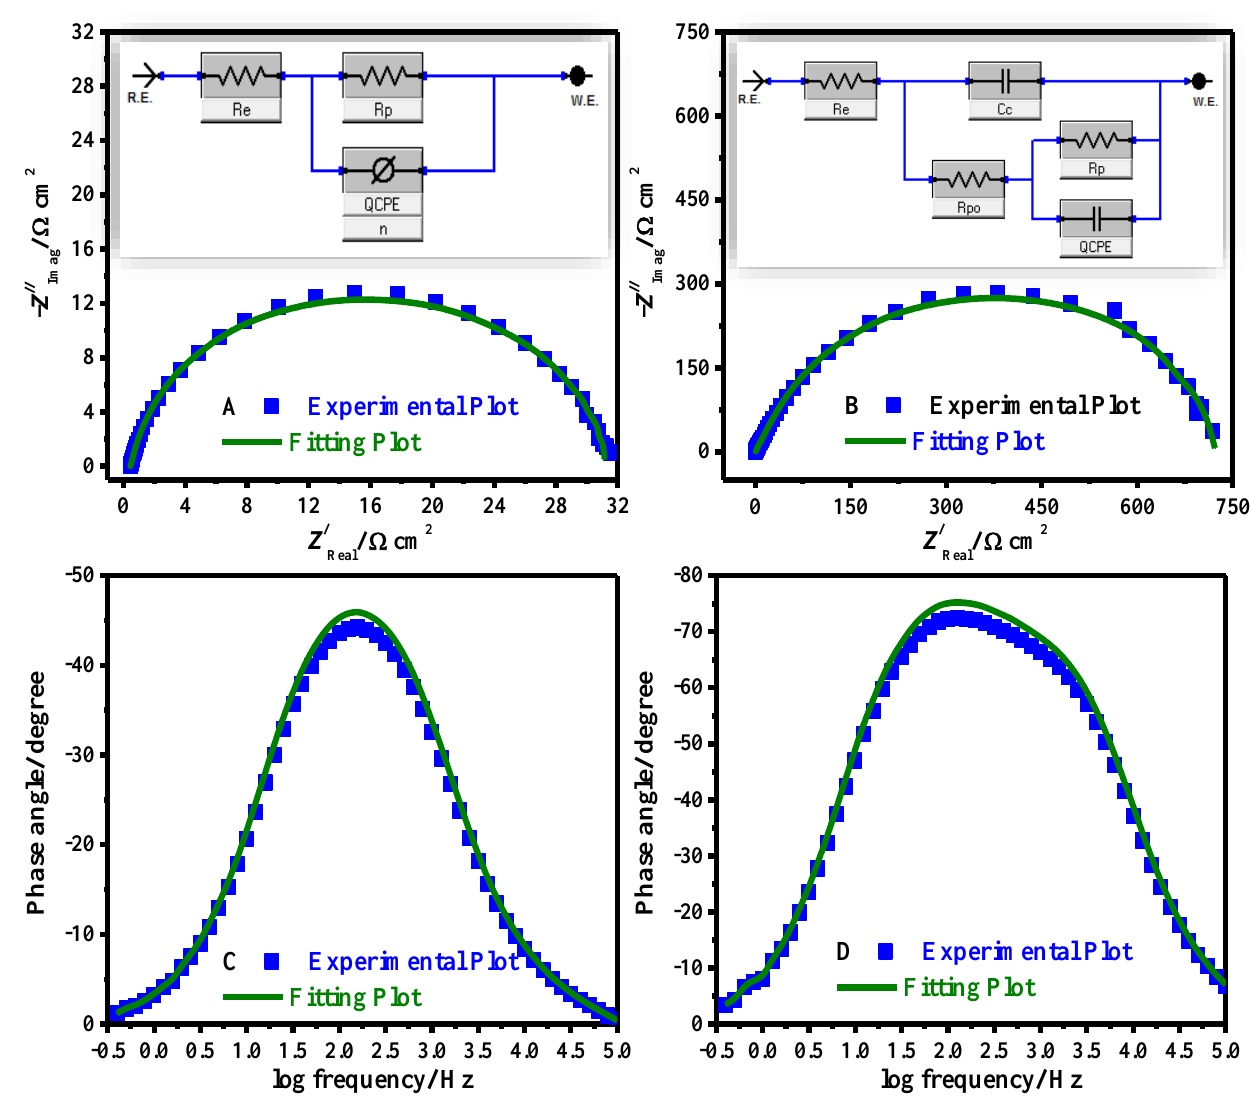
Figure 8. Comparison of experimental and fitting data ( A , B ) Nyquist, and ( C , D ) Bode phase plots in 15% HCl solution for uncoated ( A , C ) and coated using 5% CeO 2 @gelatin ( B , D ) systems. EEC for uncoated (inset A ) and coated (inset B ) systems.